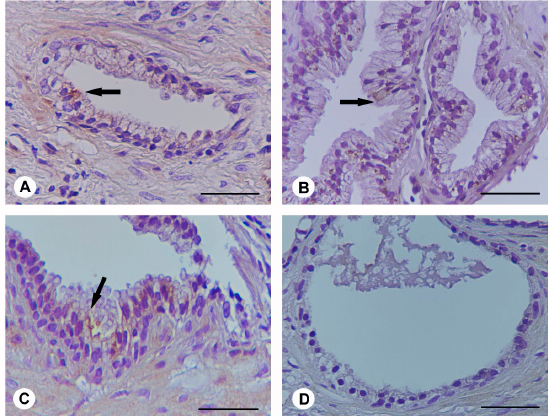
Figure 4. Prostate specific membrane antigen (PSMA) immunohistochemistry in the prostate from BPH patients at time 0; from BPH patients at 3 months; from Ser-Se-Ly treated BPH patients at time 0; and from Ser-Se-Ly treated BPH patients at 3 months. ( A , C ) In BPH subjects at both time 0 and in BPH patients treated with Ser-Se-Ly at time 0, PSMA evident immunoexpression is present (arrow); ( B ) Similar evident immunoexpression is observed in BPH patients after 3 months (arrow); ( D ) After 3 months of Ser-Se-Ly administration, no immunoexpression for PSMA is present. (Scale bar: 50 µ